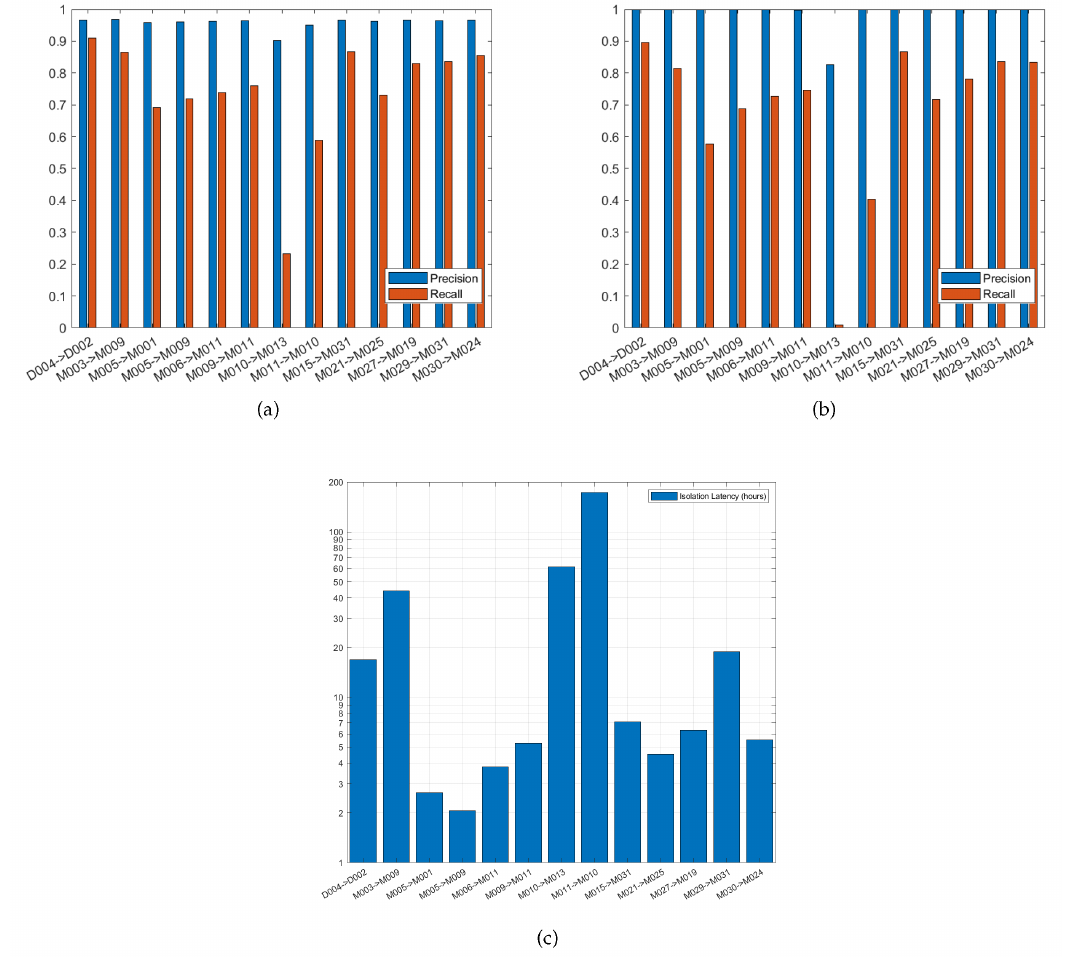
Figure 11. Moved-Location Failure: ( a ) Precision and recall of failure detection. ( b ) Precision and recall of failure isolation. ( c ) Failure isolation